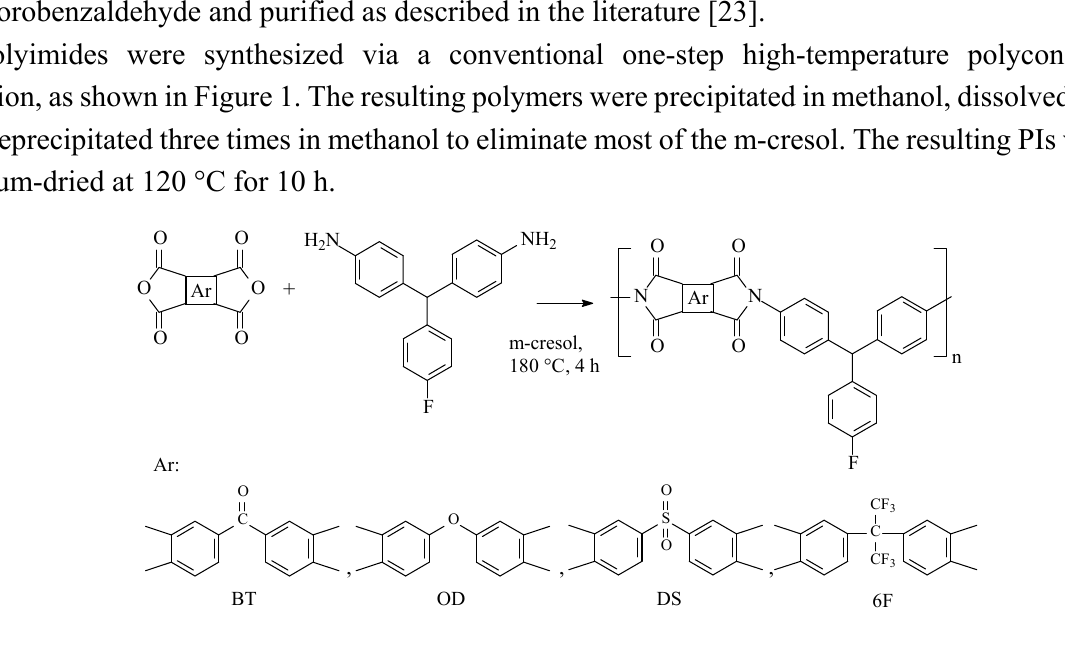
Figure 1. Chemical structures and reaction scheme for synthesizing the four polyimides reported in this